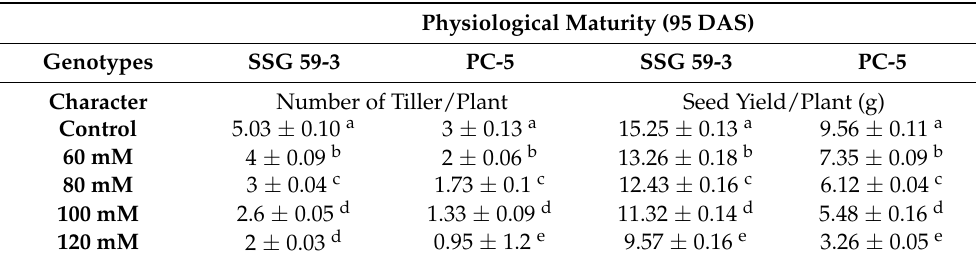
Table 5. Seed yield and number of tiller traits in sorghum at physiological